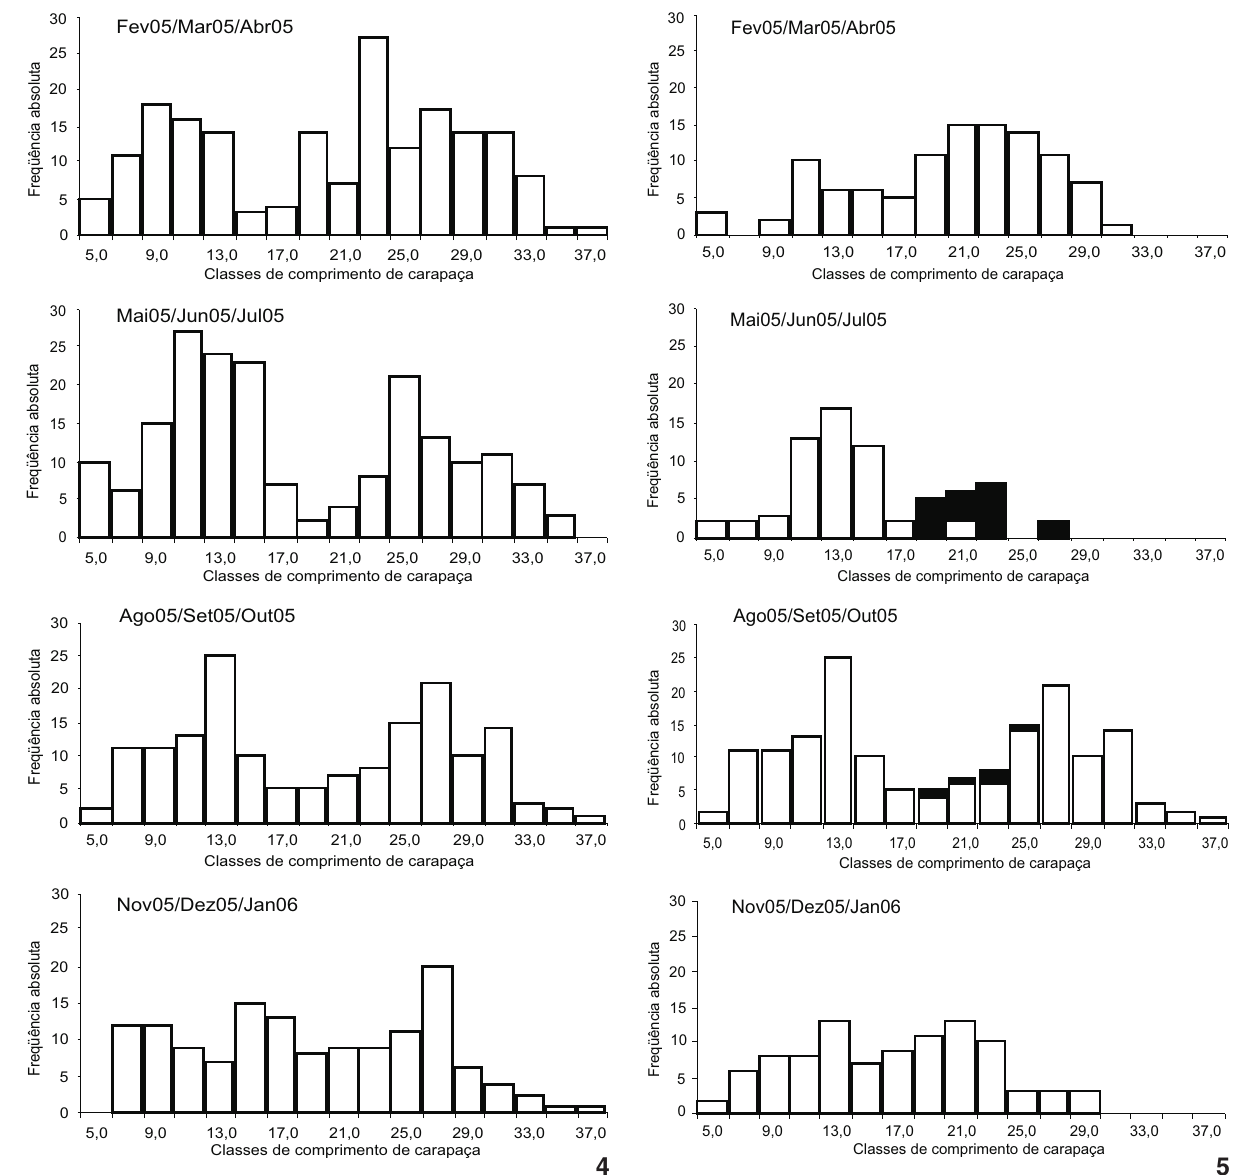
Figuras 4-5. Distribuição da freqüência absoluta de machos (4) e fêmeas (5) de A. schmitti nas classes de comprimento da carapaça (CC). As áreas escuras representam número de fêmeas